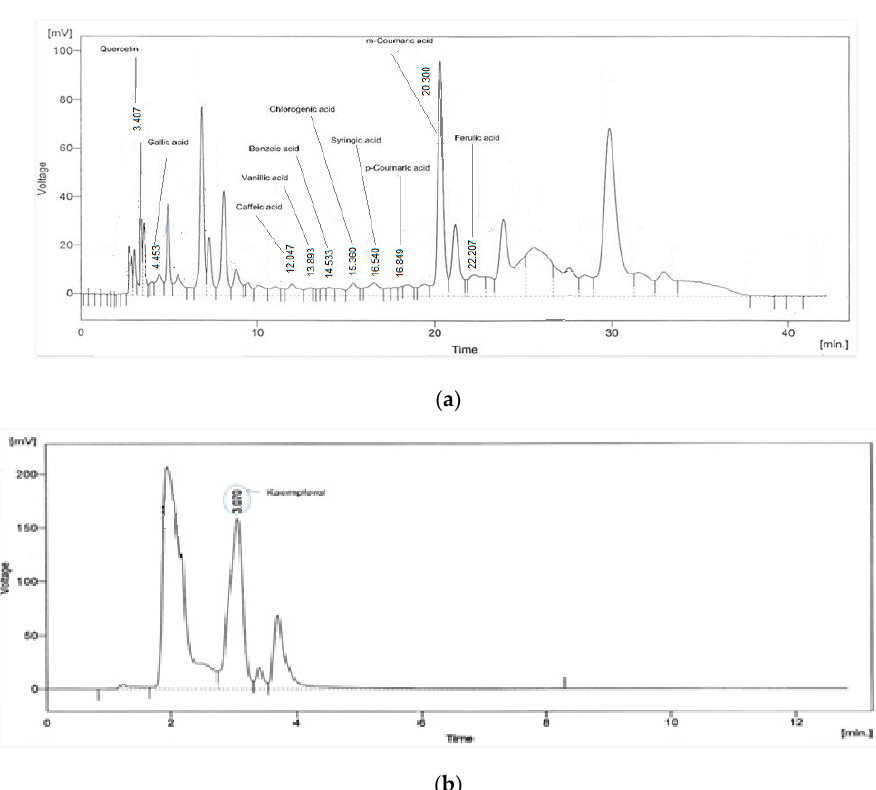
Figure 1. Chromatograms express ( a ) phenolic acids and ( b ) kaempferol of plant ( In.Cr ): HPLC peak areas of compounds identified, quantified and saponified by HPLC extracted from the crude extract of seeds of Ipomoea nil .